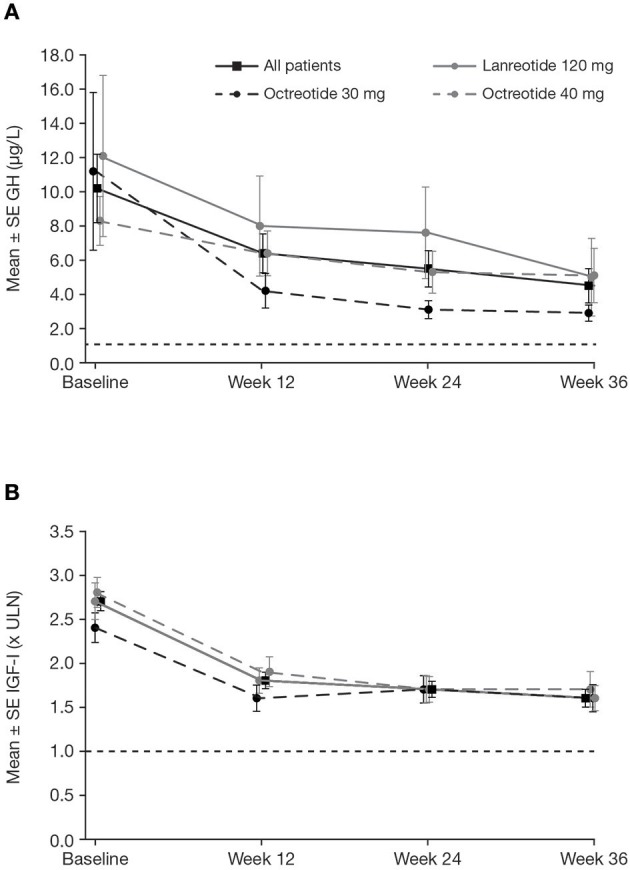
Mean ± SE (A) mGH and (B) IGF-I by visit during the core phase, in all patients and by previous first-generation SSA treatment. Reference line is (A) 1.0 μg/L and (B) ULN. SE, standard error.